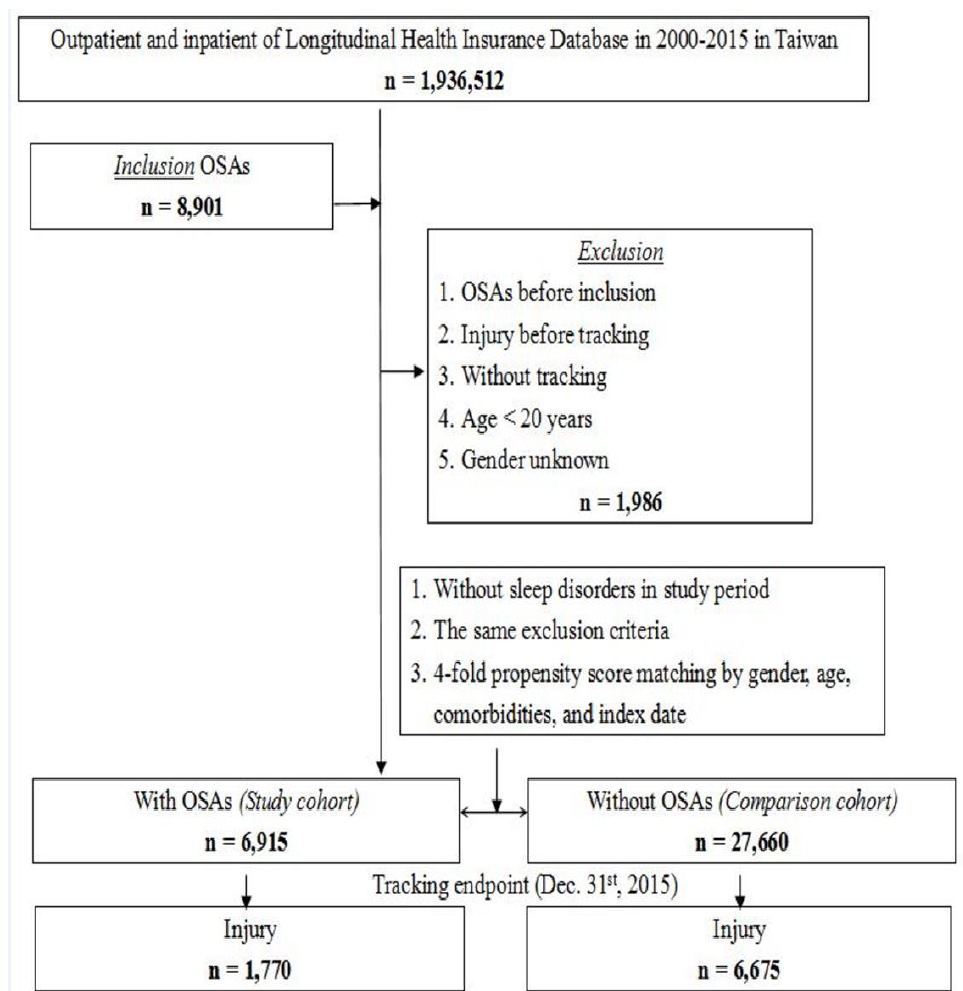
Figure 1. Flowchart of study group selection from the National Health Insurance Research Database in Taiwan.